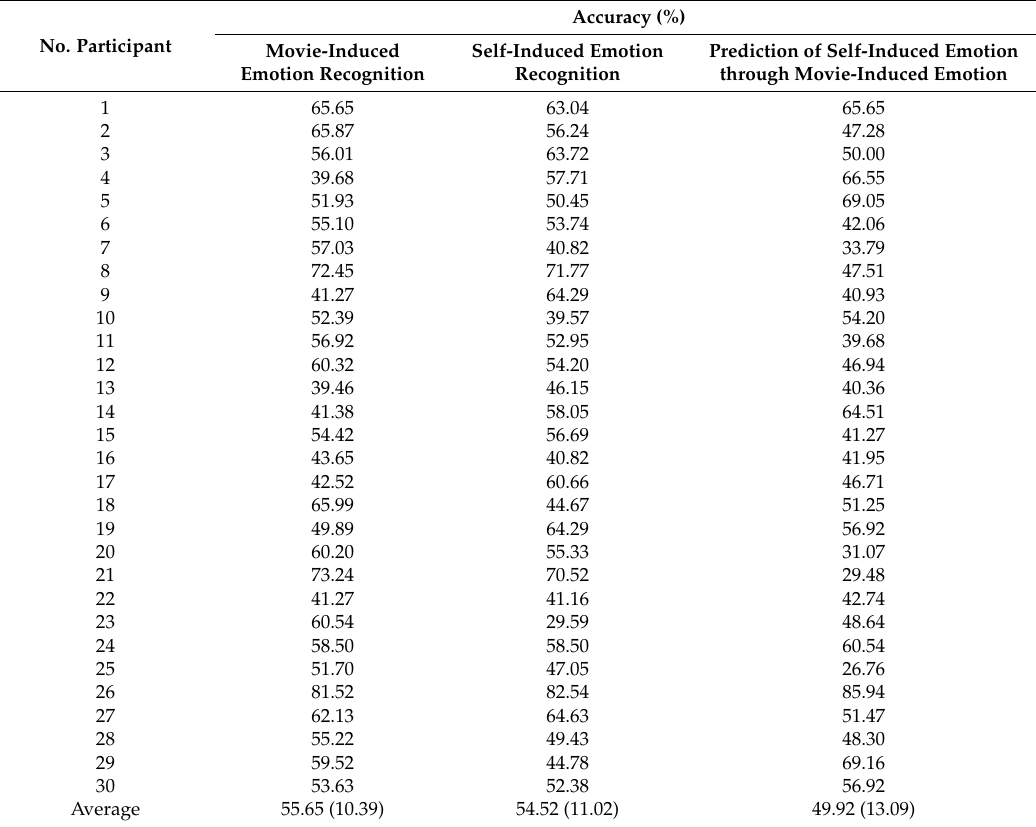
Table 6. Accuracies for the classification of emotions into six discrete categories. (Standard deviations are shown in parentheses).